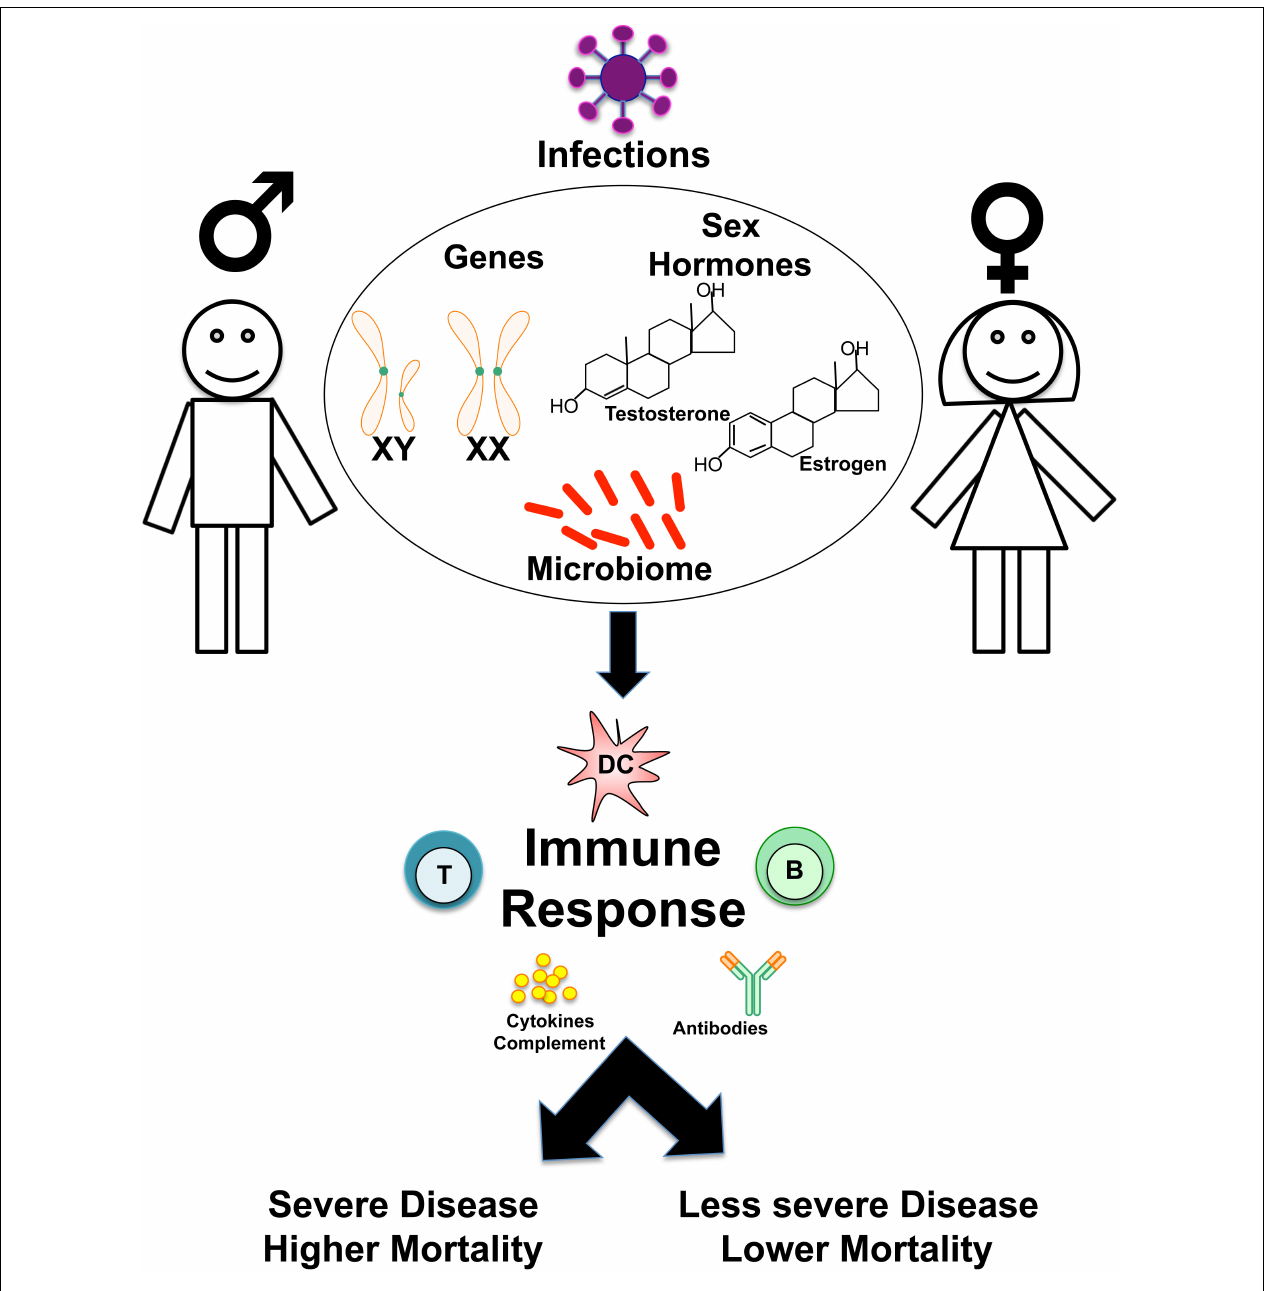
FIGURE 1 | Overview of sex-based differences in the immune response to Infections. Schematic shows how genes, sex hormones, and microbiome may influence sex-based differences in the host immune responses to infections, determining susceptibility, disease course, and clinical outcomes.